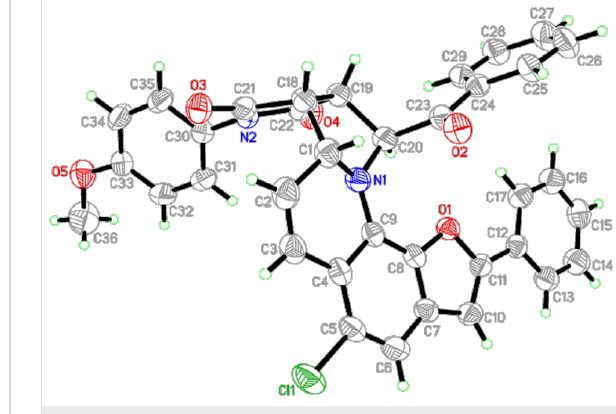
Figure 2: ORTEP diagram showing the molecular structure of 10a at 30% probability